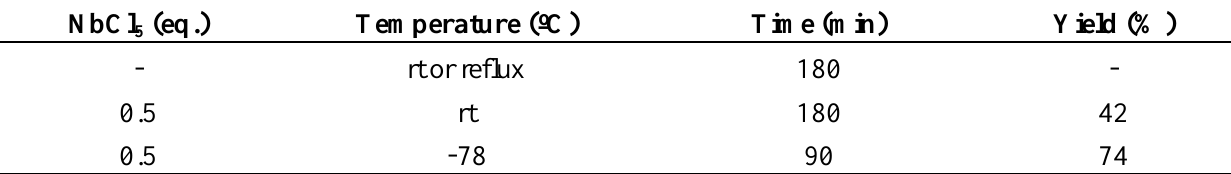
Table 1. Results obtained in the reaction of 2-cyclohexenone ( 1 ) and cyclopentadiene ( 6 ). NbCl 5